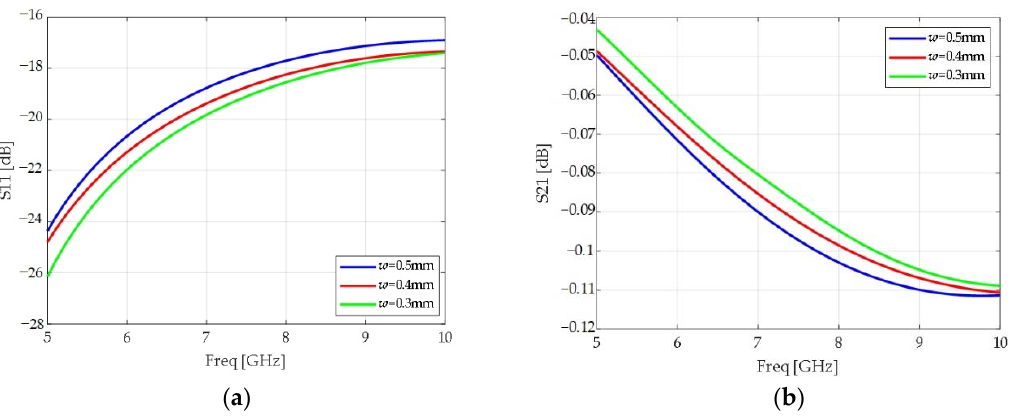
Figure 14. ( a ) S11 of lead wire interconnection with different crack widths; ( b ) S21 of lead wire interconnection with different crack widths .